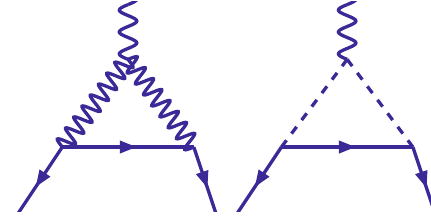
Fig. 1 The one-loop contributions to a μ in the LRTH